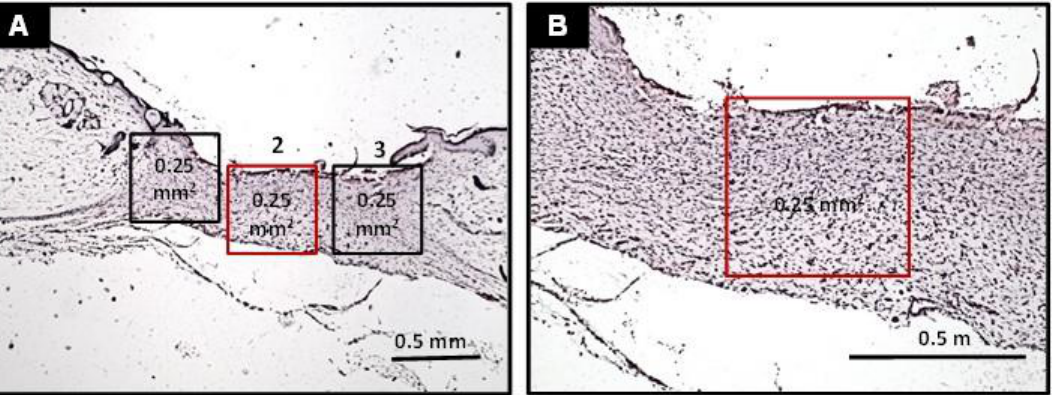
Figure 8. ( A ) Strategy of histological fields selection at low-power magnification for further histo- logical analysis (40 × ). ( B ) Photomicrograph of histological field 2 (in red) at medium magnification, showing the proper delimitation of the area (analytical area of 0.25 mm 2 ) for further histological anal- ysis (100 × ). The same procedure was also performed in areas 1 and 3 and repeated in all histological sections.